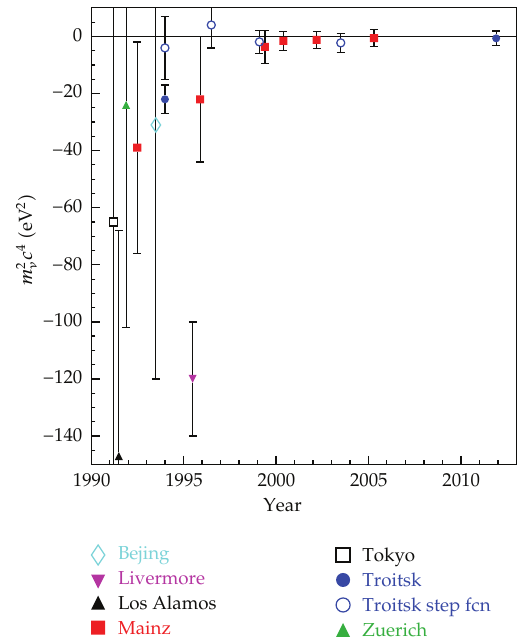
Figure 7: Results of previous tritium 𝛽 -decay experiments on the observable 𝑚 2 (𝜈 𝑒 ) . The experiments at Los Alamos, Z¨urich, Tokyo, Beijing, and Livermore [58–62] used magnetic spectrometers; the tritium experiments at Mainz and Troitsk [63–67] applied electro- static spectrometers of the MAC-E-Filter